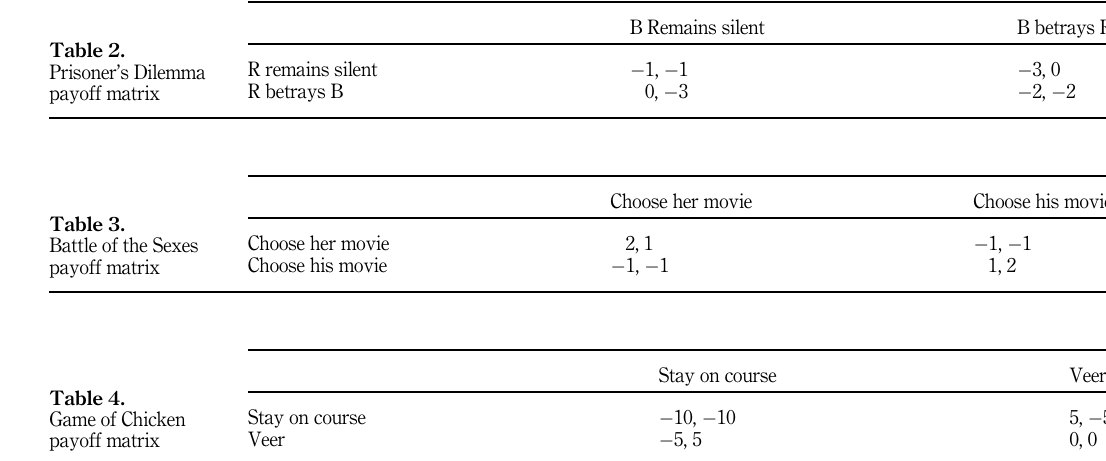
Table 4. Game of Chicken payoff